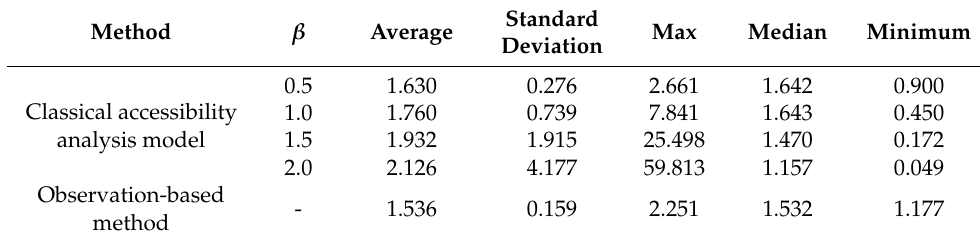
Figure 3. Distribution of actual health seeking trips based on big trajectory data in Shenzhen. Data source: bed number of GHs, Health Commission of Shenzhen; visit volume from BSU to GHs, trips inferred from LBS data of Tencent APPs. Table 2. Comparison of supply–demand ratio statistics of BSUs between observation-based and classical